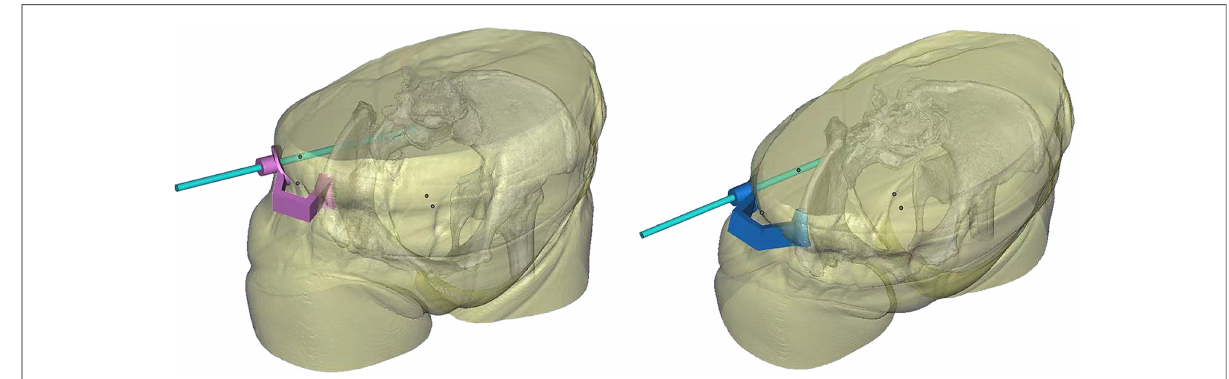
FIGURE 2 Design of the guide template. ( A ) Example of preoperative planning for S1 screw placement. ( B ) Example of preoperative planning for S2 screw